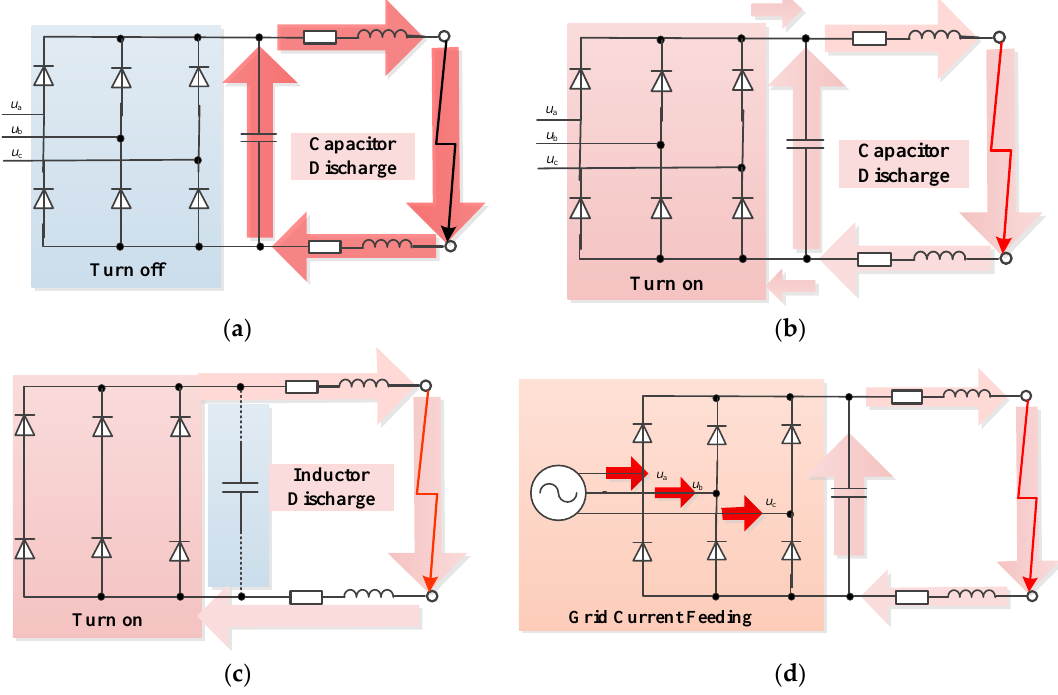
Figure 4. Four successive stages of transient response to pole-to-pole faults: ( a ) Stage 1: Capacitor discharges through the line with diodes off. ( b ) Stage 2: Capacitor discharges through the line with diodes on. ( c ) Stage 3: Inductor discharges through the line with diodes on. ( d ) Stage 4: Grid current feeds the DC link through the diodes.